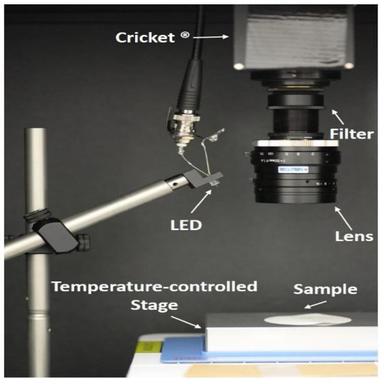
Experimental setup of the Tpx3Cam imager showing its upright orientation, LED excitation source, T-controlled stage and phosphorescent sample placed on it.